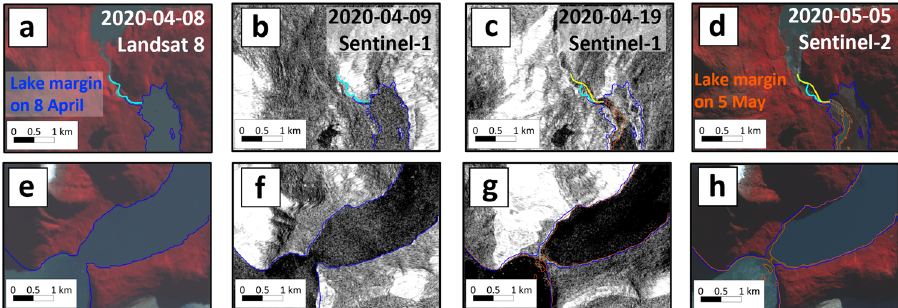
Fig. 3 Satellite images showing initiation of the drainage event. The images were acquired by Landsat-8, Sentinel-1, Sentinel-2 for the locations indicated by the magenta boxes in Fig. 1a. The acquisition dates are ( a and e ) 8 April 2020, ( b and f ) 9 April 2020, ( c and g ) 19 April 2020, and ( d and h ) 5 May 2020. Cyan and yellow lines in a – d indicate the outlet stream as observed on the optical images on 8 April and 5 May, respectively. The blue and orange lines are the same for the lake